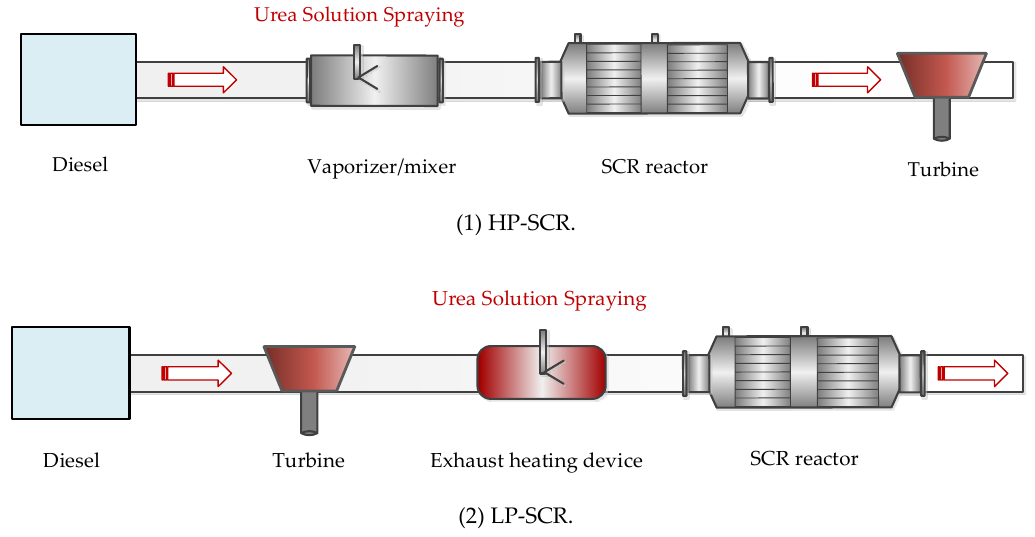
Figure 16. Schematic diagram of the marine diesel engine high-pressure SCR system and low-pressure SCR system.